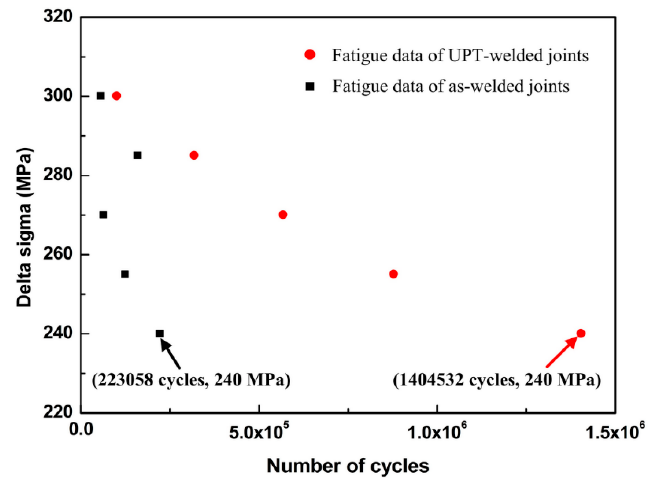
Figure 5. Fatigue data of UPT-welded joints and as-welded joints.